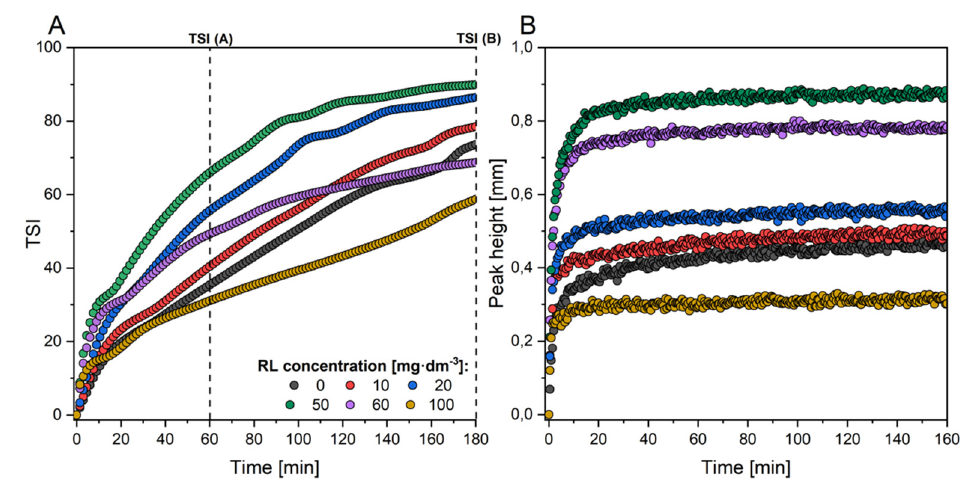
Figure 5. Kinetics of destabilisation of the dolomite suspension ( A ). Peak height curves that define the relationship between sediment thickness and the time over which it increases ( B